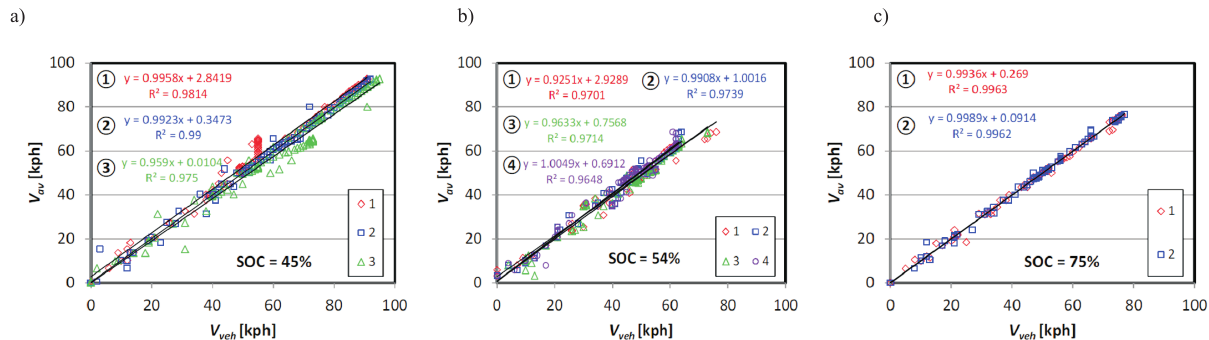
Fig. 8. The analysis of linear regression of average and instantaneous speed value in the tests runs at different initial SoC: a) 45%, b) 54%, c) 75% Rys. 8. Analiza regresji liniowej wartości prędkości średniej i chwilowej testu badawczego przy zróżnicowanym początkowym SOC: a) 45%, b) 54%, c)